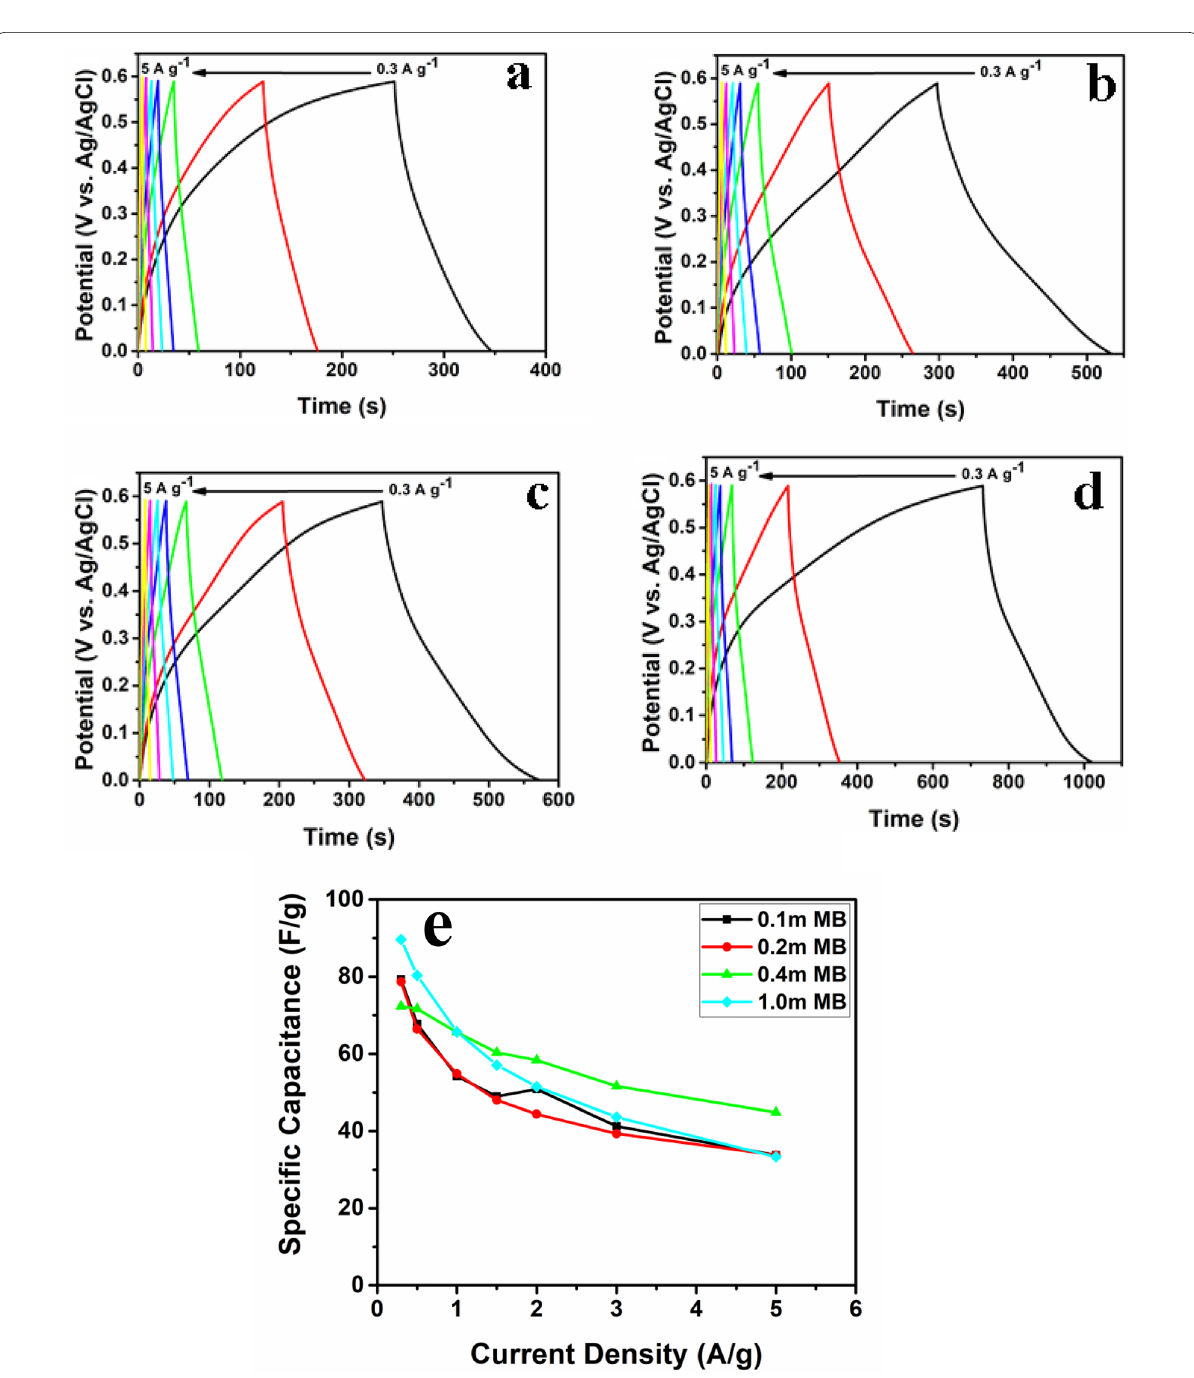
Fig. 6 Charge/discharge curves at different current densities of MB carbon fiber fabrics electrodes within an operating potential of 0 ⁓ 0.60 V (vs. Ag/AgCl) at different current densities 0.3 to 5 A g − 1 a 0.1 mM MB, b 0.2 mM MB, c 0.4 mM MB, d 1.0 mM MB and e specific capacitance comparison at different current